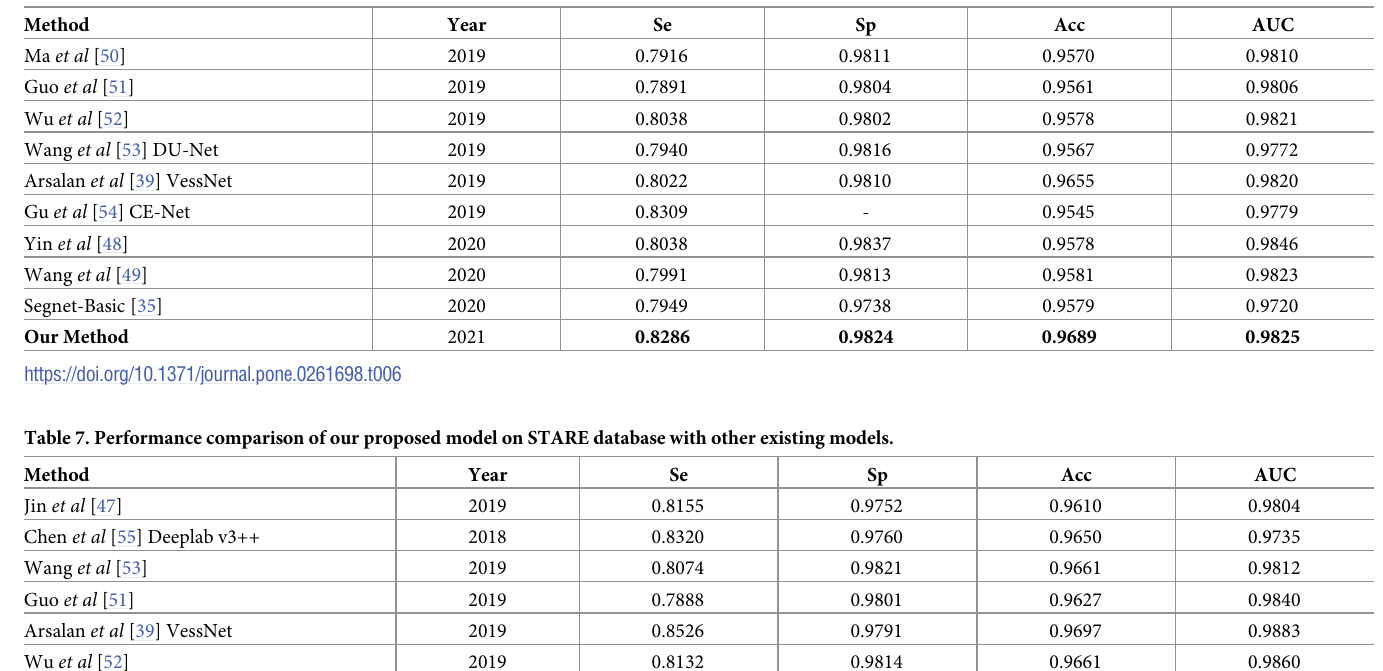
Table 6. Performance comparison of our proposed model on DRIVE dataset with other existing models.